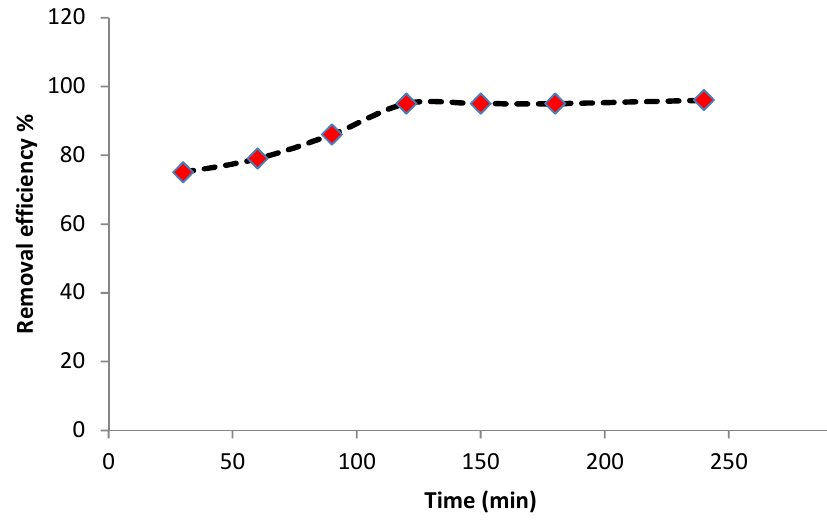
Figure 4. Effect of contact time on biosorption of arsenate by